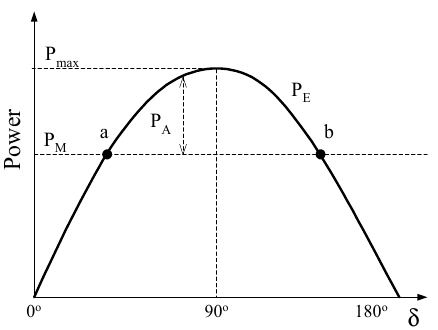
Figure 1. The power-angle curve for EAC. Typical stable response trajectories are oscillations, eventually settling into a stable equilibrium (point a).